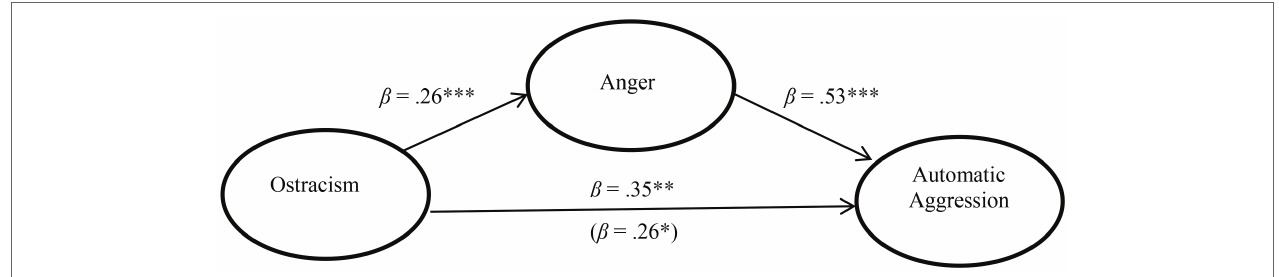
FIGURE 1 | Anger partially mediates the effect of ostracism on automatic aggression in Study 3. Note: * p < 0.05; ** p < 0.01; *** p < 0.001.